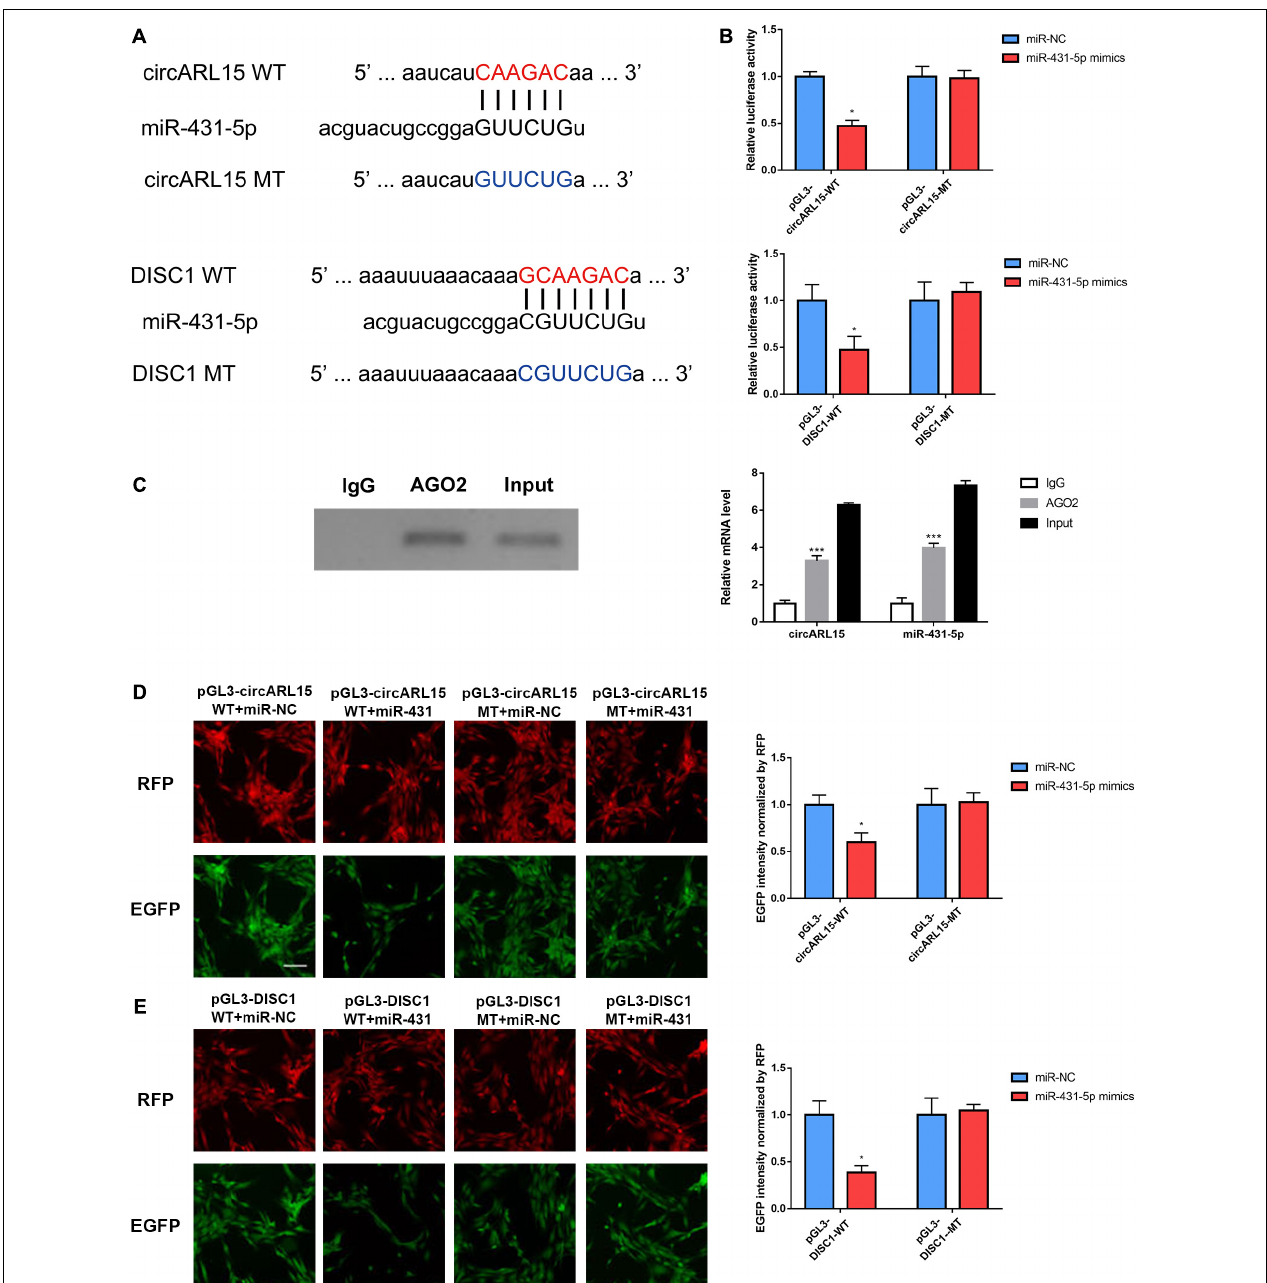
FIGURE 4 | circARL15 and DISC1 bind directly to miR-431-5p in IDD. (A) The binding region of miRNAs in circARL15 and DISC1. (B) A luciferase reporter assay confirmed that miR-431-5p reduced the luciferase intensity in cells co-transfected with circARL15 WT and DISC1 WT. (C) RIP assay was used to detect the circARL15 and miR-431-5p mRNA levels (right). The AGO2 protein level was determined by Western blotting (left). (D,E) NP cells were co-transfected with an EGFP reporter plasmid or the mutant vector and the pDsRed-C1 plasmid, either alone or in combination with a miR-431-5p mimic. Forty-eight hours post-transfection, EGFP and RFP levels were measured * p < 0.05, *** p <